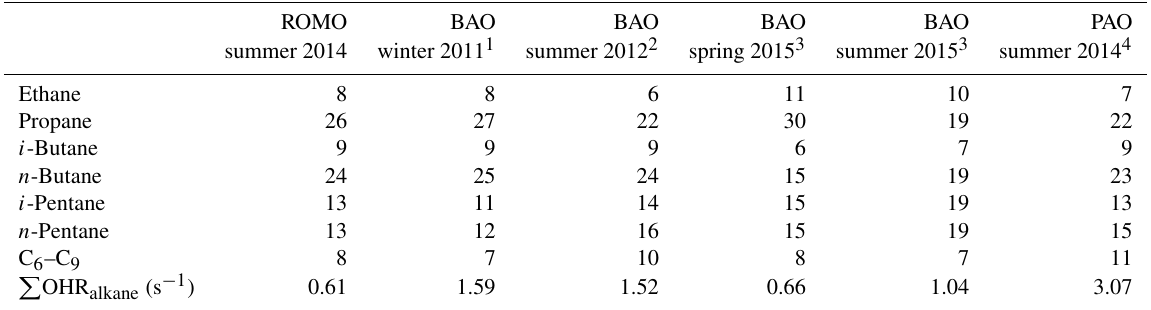
Table 4. Percentage contributions of the light alkanes to the alkane OHR during the oil- and gas-influenced events at ROMO during FRAPPÉ (total alkane OHR = 0.62s − 1 ) and from measurements at the BAO and PAO.